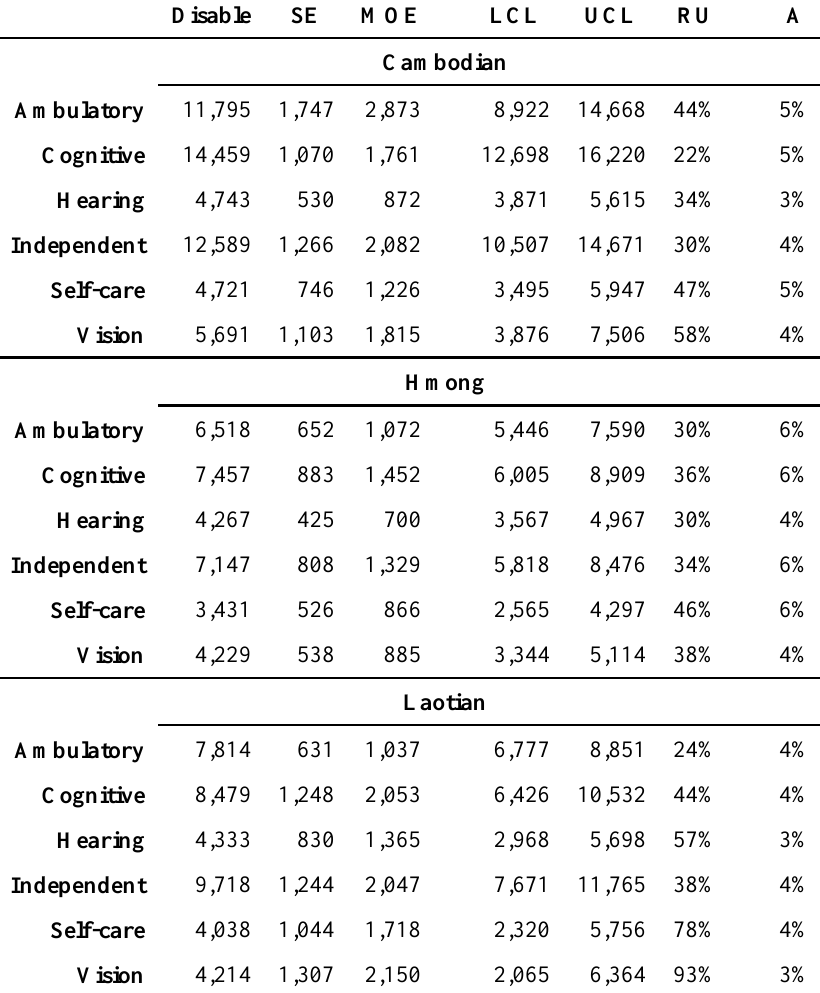
Table 2: Weighted number of Cambodian, Hmong, and Laotians with disabilities and corresponding estimate precision